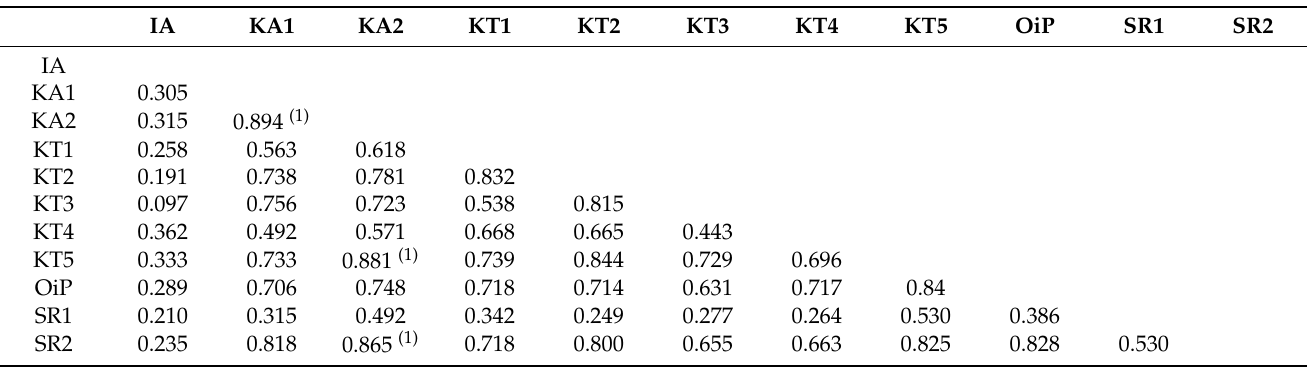
Table 3. Assessment of discriminant validity of the path model in the initial phase using the HTMT criterion.